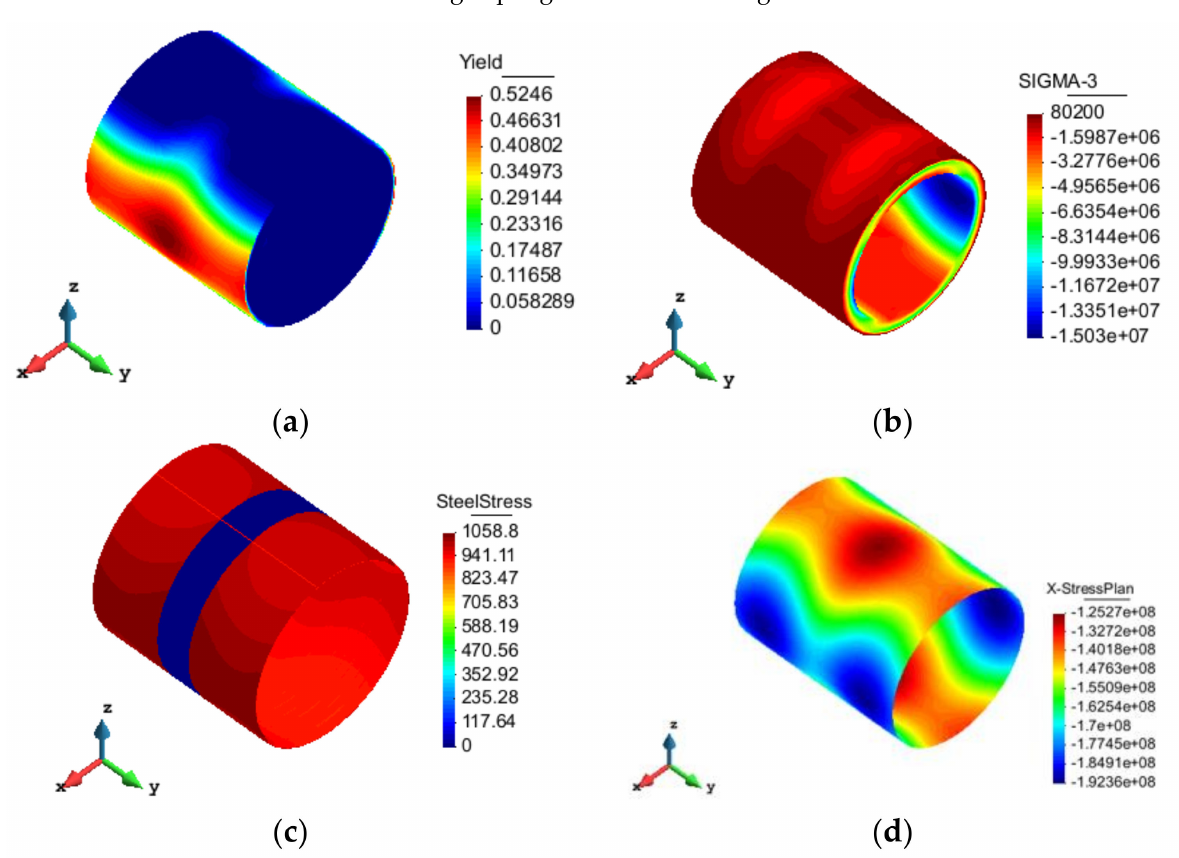
Figure 9. Nephogram of case 1: ( a ) damage, ( b ) 3rd principal stress, ( c ) wire stress, ( d ) cylinder stress. The maximum damage value of the mortar is 0.52, which increases by 0.16 compared with the pre-breaking stage. The damage to the outer concrete starts growing at the springline in the broken area, with the maximum value of 0.24. The maximum stress in the outer-layer wires increases to 1058.8 MPa, with the increment of 19 MPa compared with the pre-breaking stage. Meanwhile, the stress in the inner wires near the pre-stressing loss zone also increases, which increases to around 11.0 MPa at the springline. Once the outer-layer wire in the middle of pipe is broken, the stress in the unbroken and inner wire on the side of the broken area will increase, and the stress in the cylinder will rise. The damage on